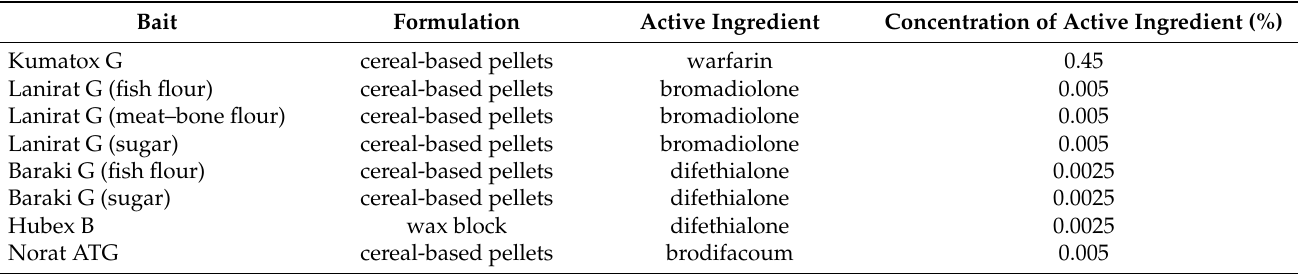
Table 1. Overview and characterization of rodenticide baits included in the house mouse choice and no-choice feeding